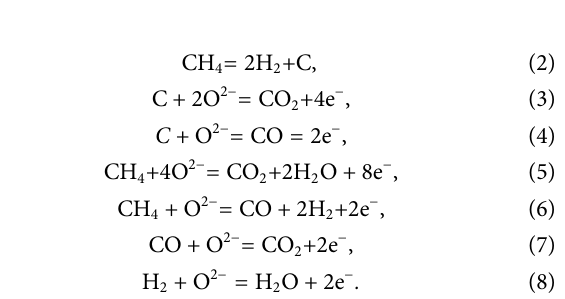
Frontiers in Energy Research |